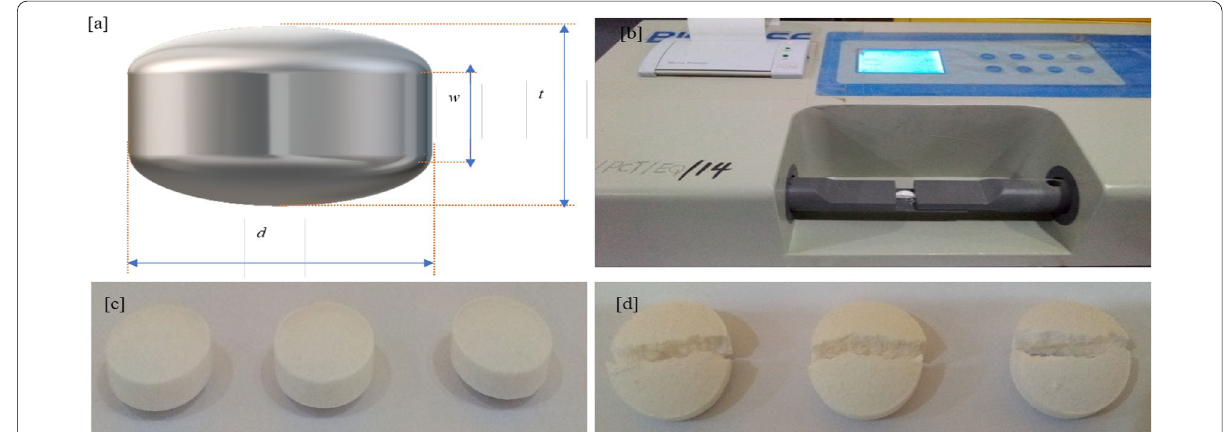
Fig. 1 Schematic presentation of biconvex tablet dimensions ( a ). d : compact diameter, t : total axial thickness, w : compact wall height (central cylinder thickness). Digital tablet hardness tester (Model THT-2, Biobase, India) ( b ). Samples of experimental biconvex compacts ( c ). Diametral fracture pattern of orodispersible α-lactose-starch diluent compacts ( d